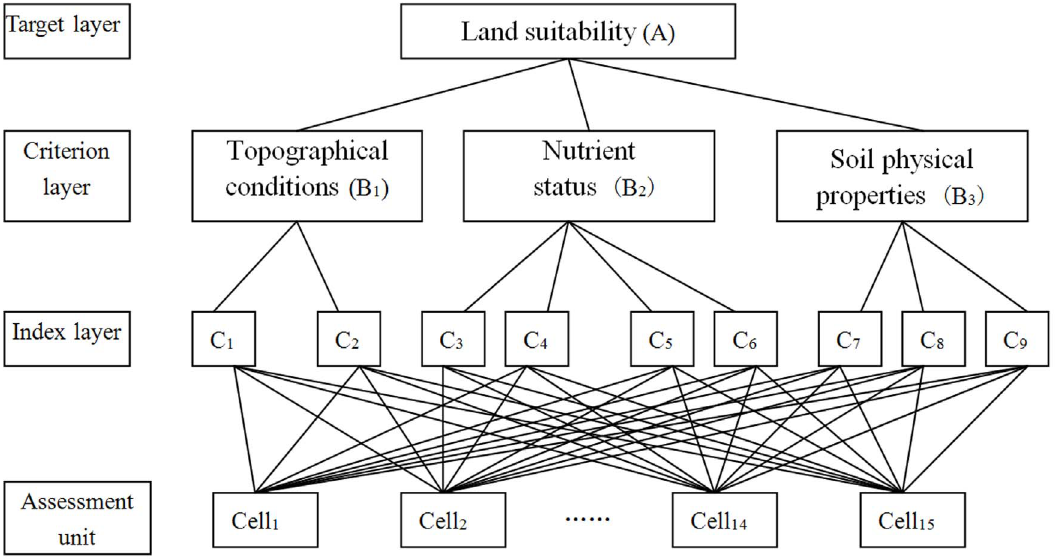
Figure 2. Hierarchical structure of land suitability.